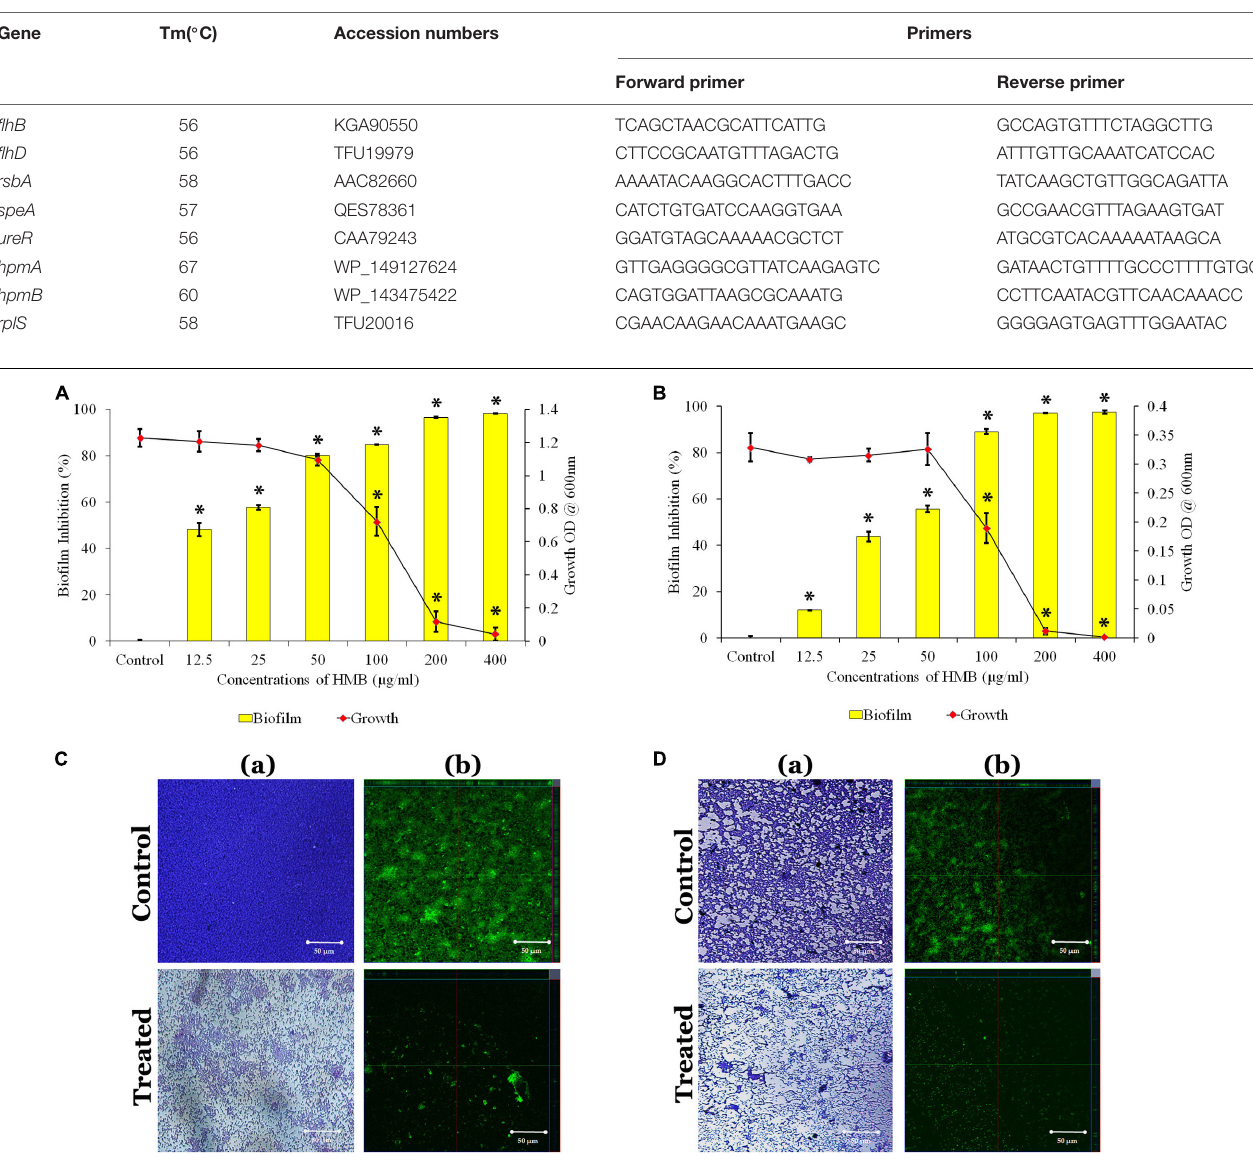
TABLE 1 | List of virulence genes in P. mirabilis and their primer sequences.